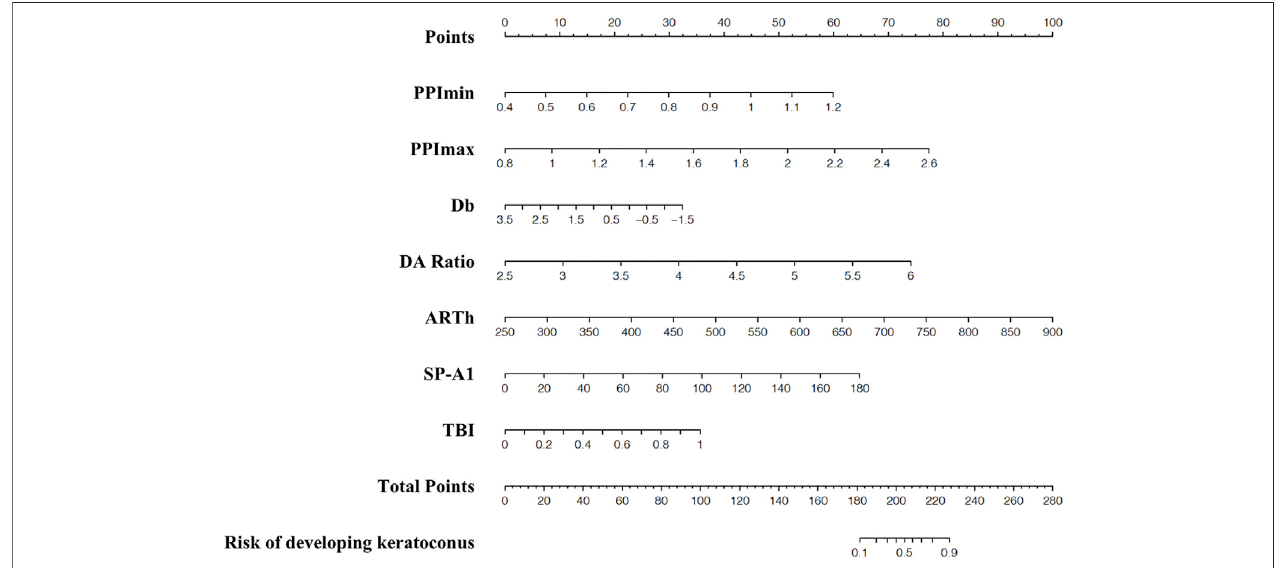
FIGURE 2 | Nomogram for predicting developed-into-keratoconus in VAE-NT patients. VAE-NT, de fi ned clinical ectasia in one eye and normal tomography.